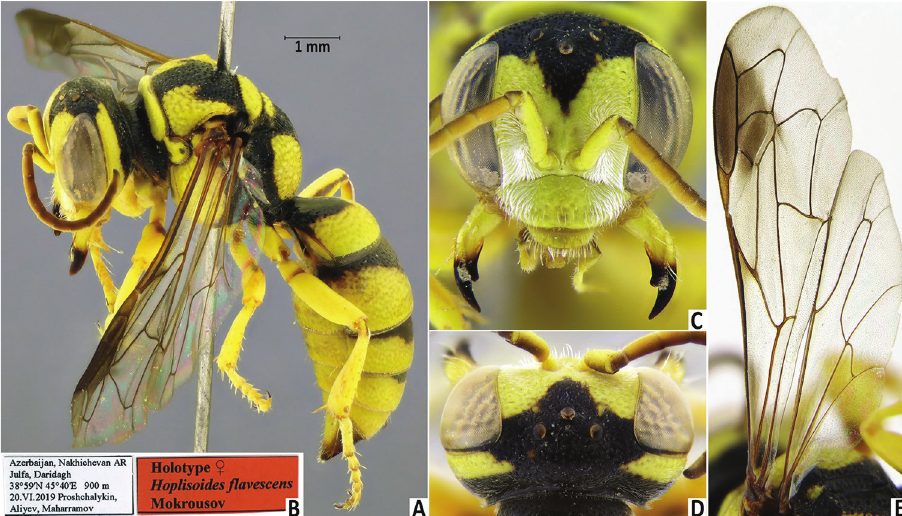
Figure 1. Hoplisoides flavescens Mokrousov, sp. nov., holotype, female: A habitus, dorsolateral view B labels C head, frontal view D head, dorsal view E wings, dorsal